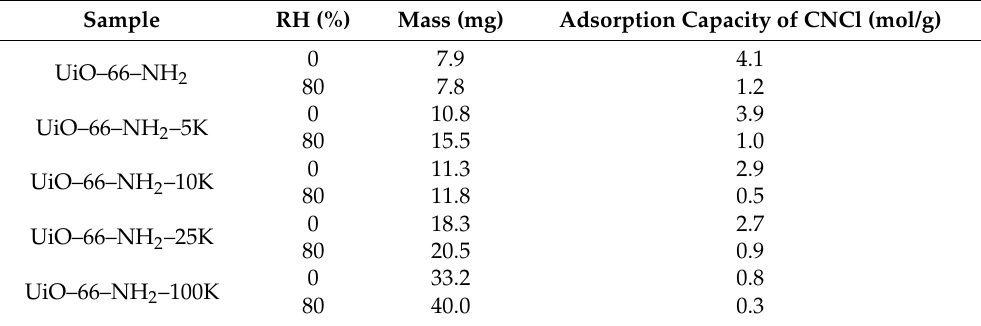
Table 4. Protective performance of UiO–66–NH 2 formed with varying tableting pressure on CNCl [35]. Sample